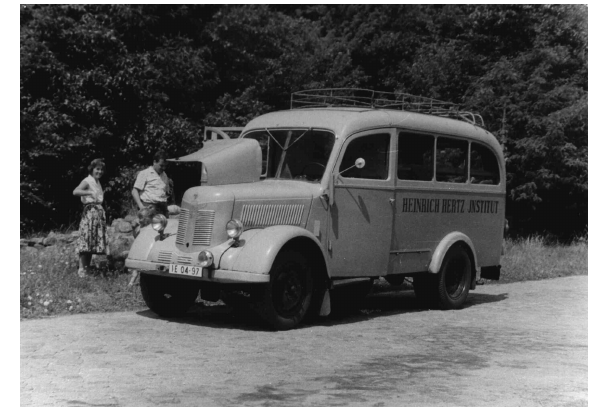
Figure 6. The staff for establishment and operation of the sta- tion travelled in turns from Berlin to Juliusruh, using the HHI’s own minibus. This vehicle soon became well known on the Wittow Peninsula. Sometimes the men were accompanied by their families.